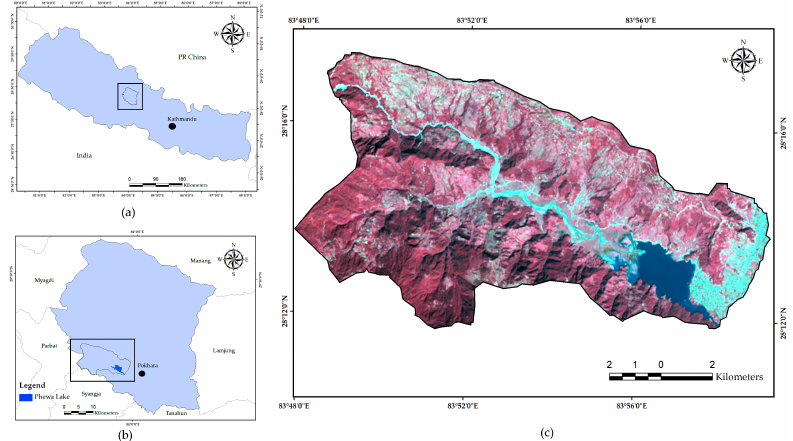
Figure 1. Map showing: ( a ) Kaski District within Nepal; ( b ) Phewa Lake watershed within Kaski District; and ( c ) a false color composition of Landsat 8 OLI (2017) subsetted to Phewa Lake watershed